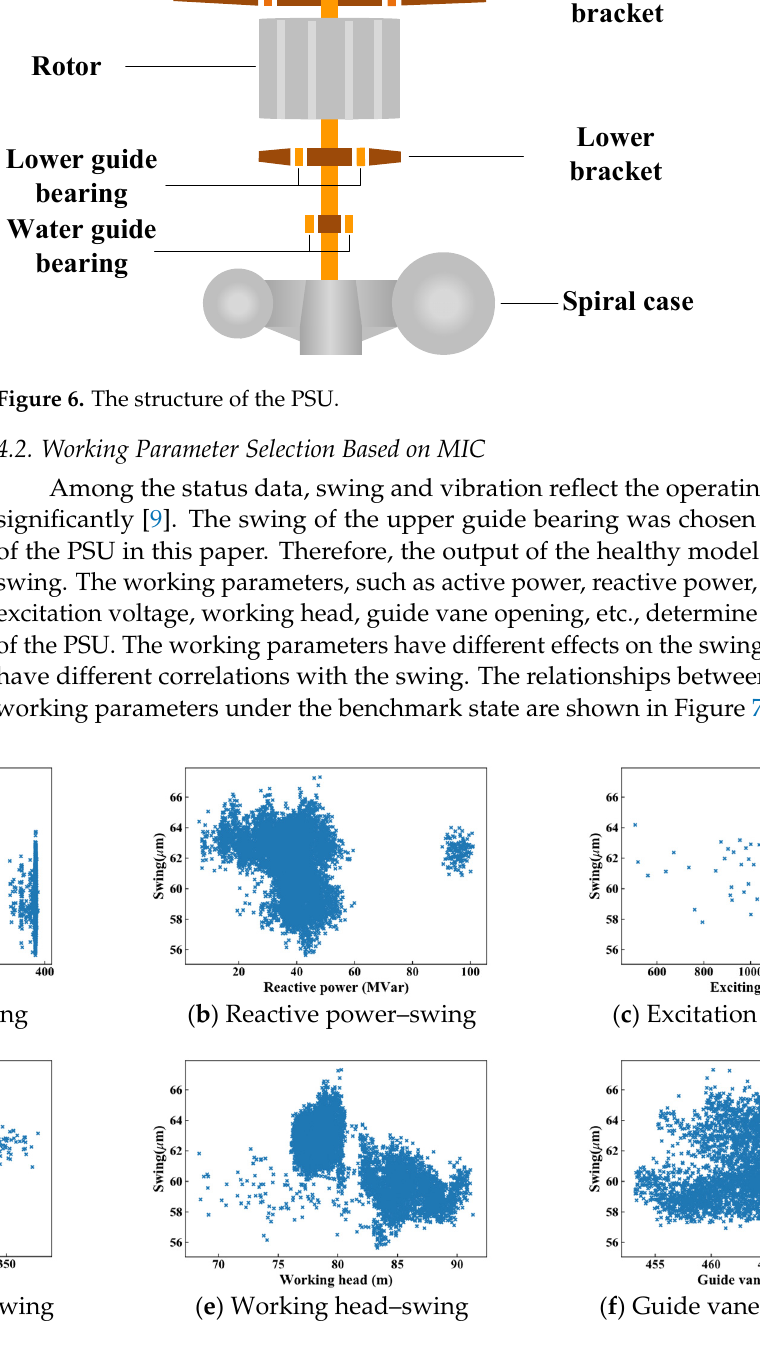
Figure 7. Relationships between working parameters and swing.